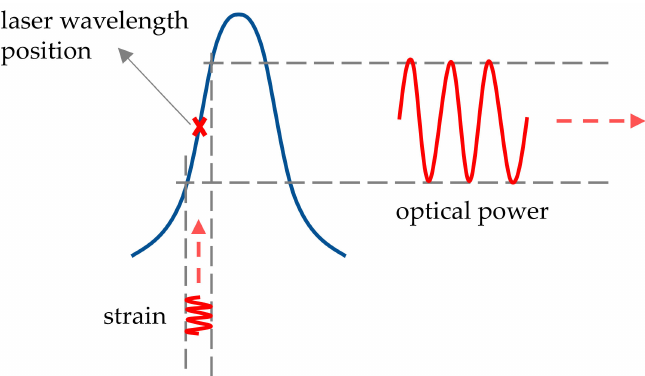
Figure 1. Edge-filtering fiber Bragg grating (FBG) interrogation: a narrow linewidth laser is set at the steepest slope of a Bragg peak. When a strain signal shifts (or deforms) the Bragg peak, the reflected optical power will change